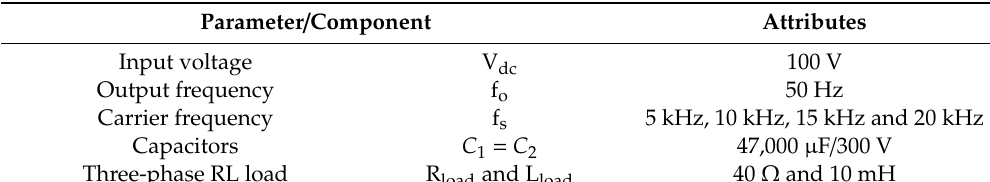
Table 3. Parameters used in simulation.